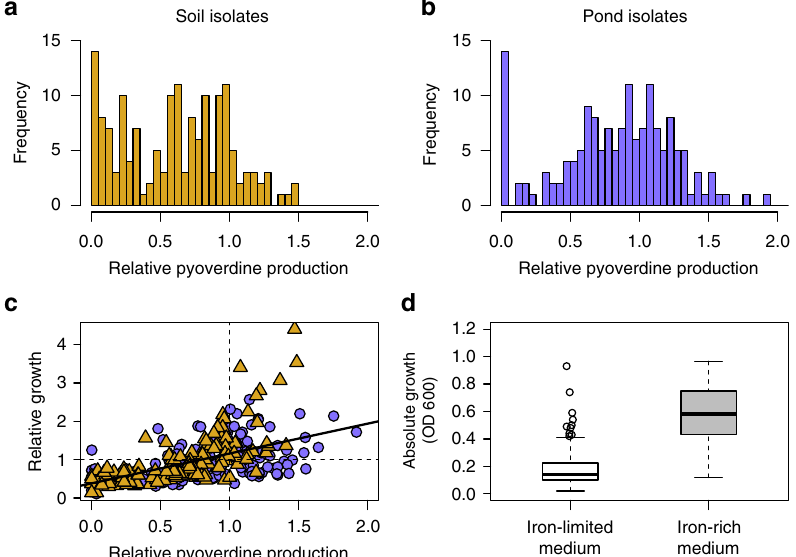
Fig. 1 Pyoverdine production and growth of natural Pseudomonas isolates. The natural soil ( a , n = 158) and pond ( b , n = 157) isolates varied greatly in their levels of pyoverdine production. Pyoverdine production was measured in iron-limited casamino acids (CAA) medium, and was scaled relative to the production levels of characterised laboratory reference strains (Supplementary Table 1). c There was a signi fi cant positive correlation ( solid line ) between growth of the isolates in iron-limited media and their pyoverdine production level, suggesting that pyoverdine is important for growth. Values are given as means across three replicates for soil ( yellow triangles ) and pond ( purple circles ) isolates. Dotted lines denote growth and pyoverdine production of reference strains. d While the growth of natural isolates was strongly limited in media with low iron availability, all strains grew well when iron (40 µ M FeCl 3 ) was added. This demonstrates that all natural isolates could use CAA as a nutrient source. Box plots show the median, fi rst and third quartile, and the